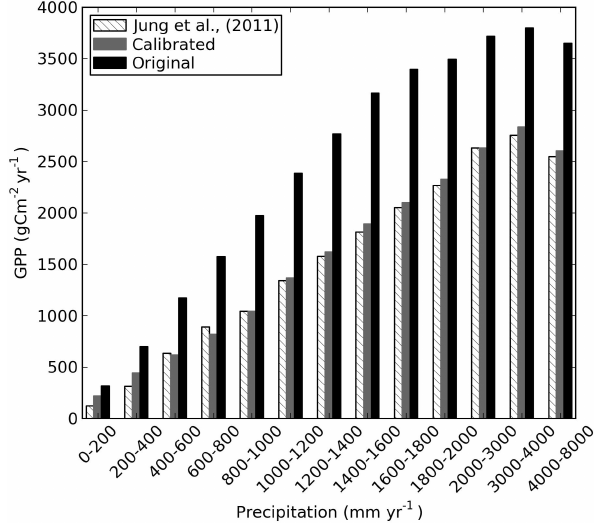
Figure 1. Annual GPP as a function of annual precipitation ac- cording to Jung et al. (2011) (dashed bar); model simulation before (black bar) and after calibration (grey